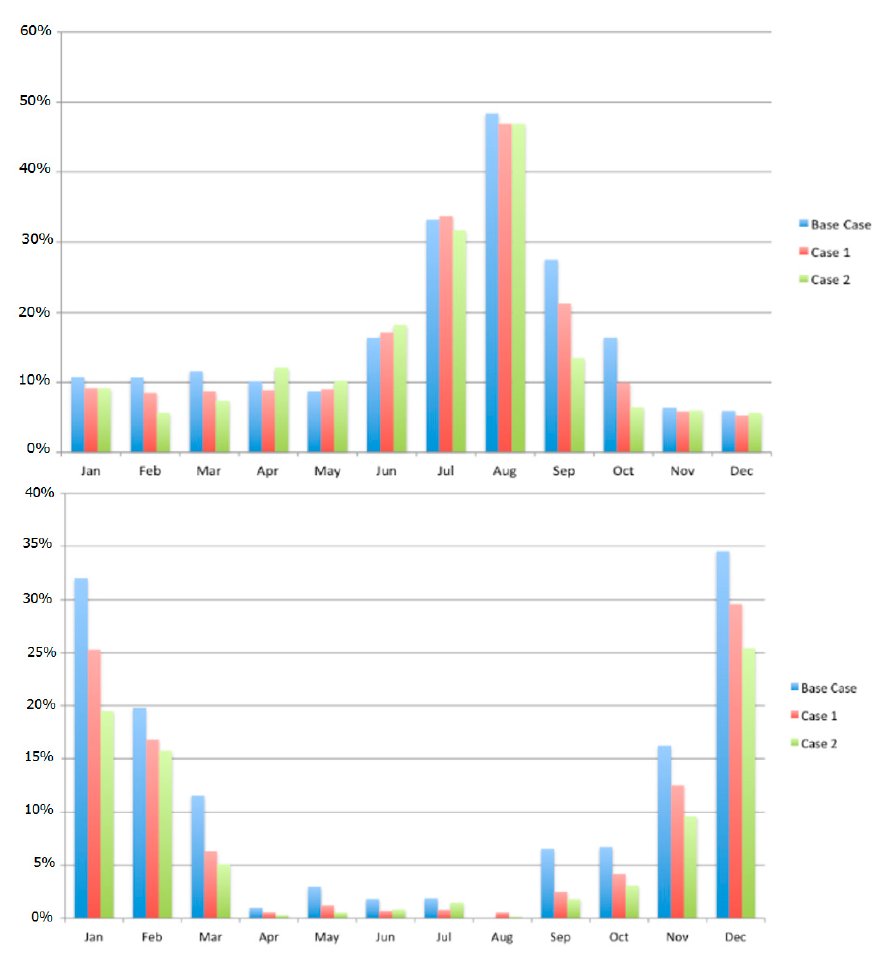
Figure 16. Percentage of hours in each month in which the SICI-SUD line is congested, in the three cases